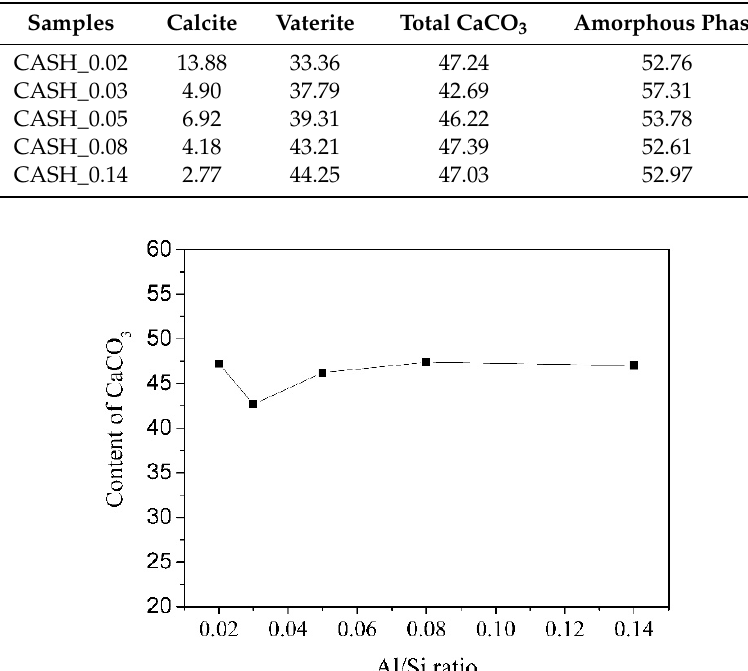
ff ect of Al / Si ratio on the content of CaCO Figure 7. The effect of Al/Si ratio on the content of CaCO 3. Figure 7. The e